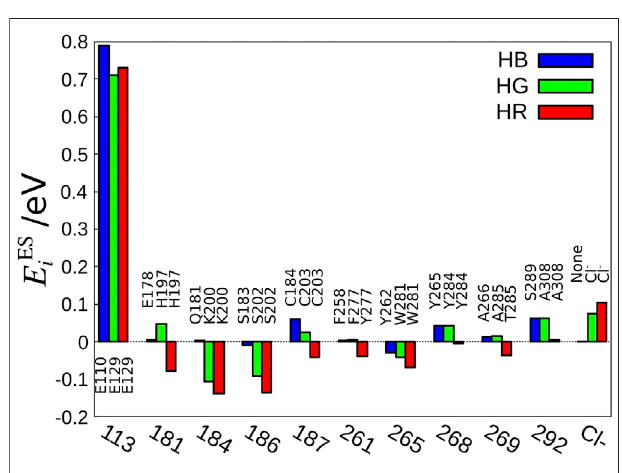
FIGURE 3 | Amino acid sequences important for the color tuning. The amino acid number of bovine rhodopsin is shown as the standard value because the amino acid numbers are different among HB, HG, and